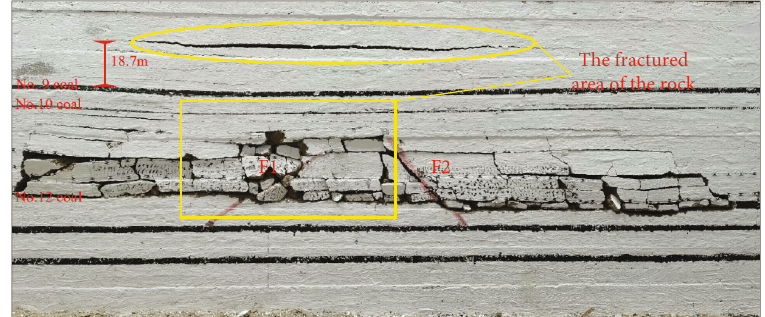
Figure 11: Fracture distribution diagram of similar simulation.